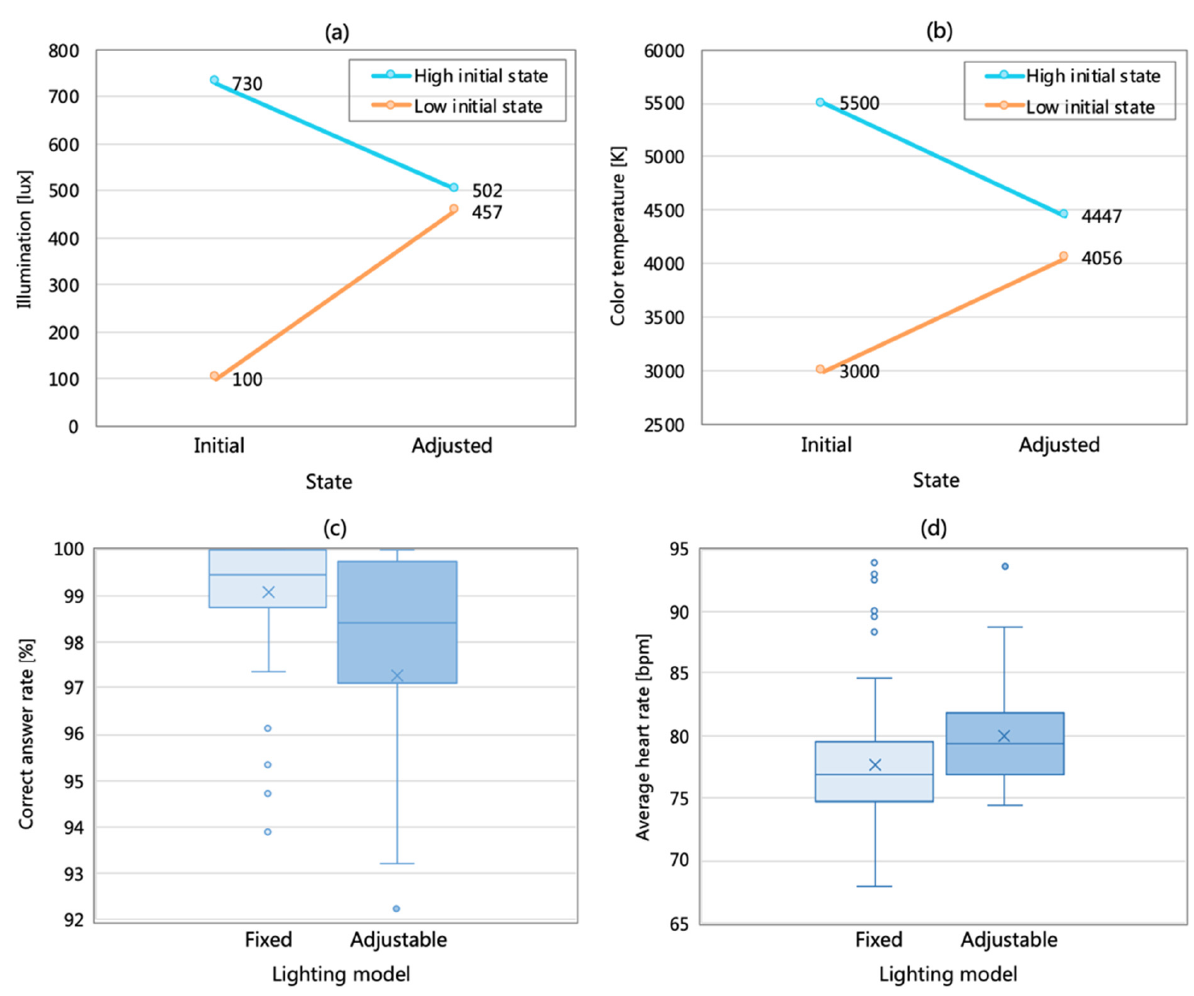
Figure 6. Illumination and CCT in different states of adjusted lighting and answer rate and average heart rate in fixed and adjusted state: ( a ) Illumination in different states of adjusted lighting; ( b ) CCTs in different states of adjusted lighting; ( c ) The correct answer rates in fixed and adjusted state; ( d ) The average heart rates in fixed and adjusted state.